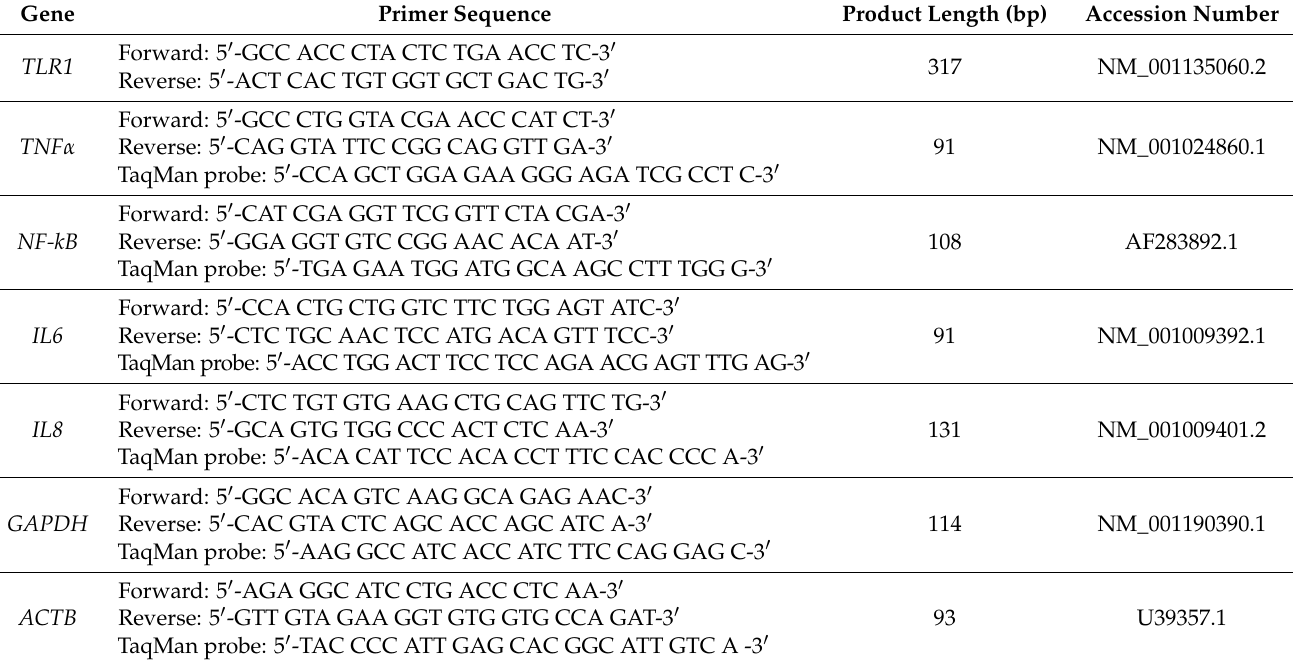
Table 1. List of primers used for the conventional and semi-quantitative real time (TaqMan)